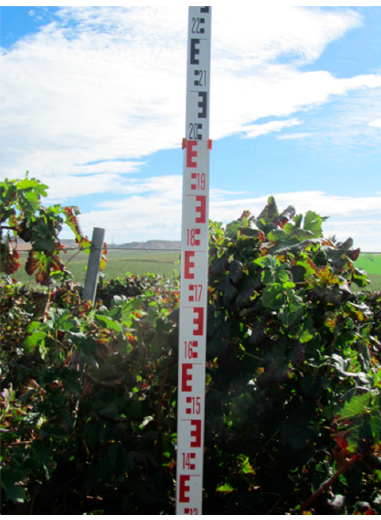
Figure 3. An example of vine height measurement.